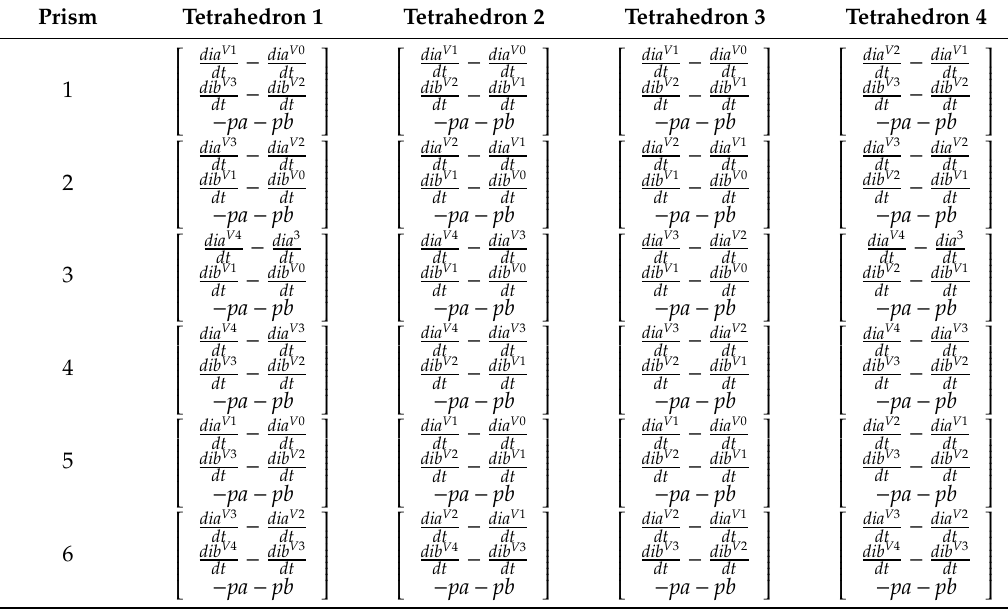
Table 8. Selection of the saturation saliency position scalars P a , P b , and P c for a fault-tolerant PMSM drive under a loss of phase